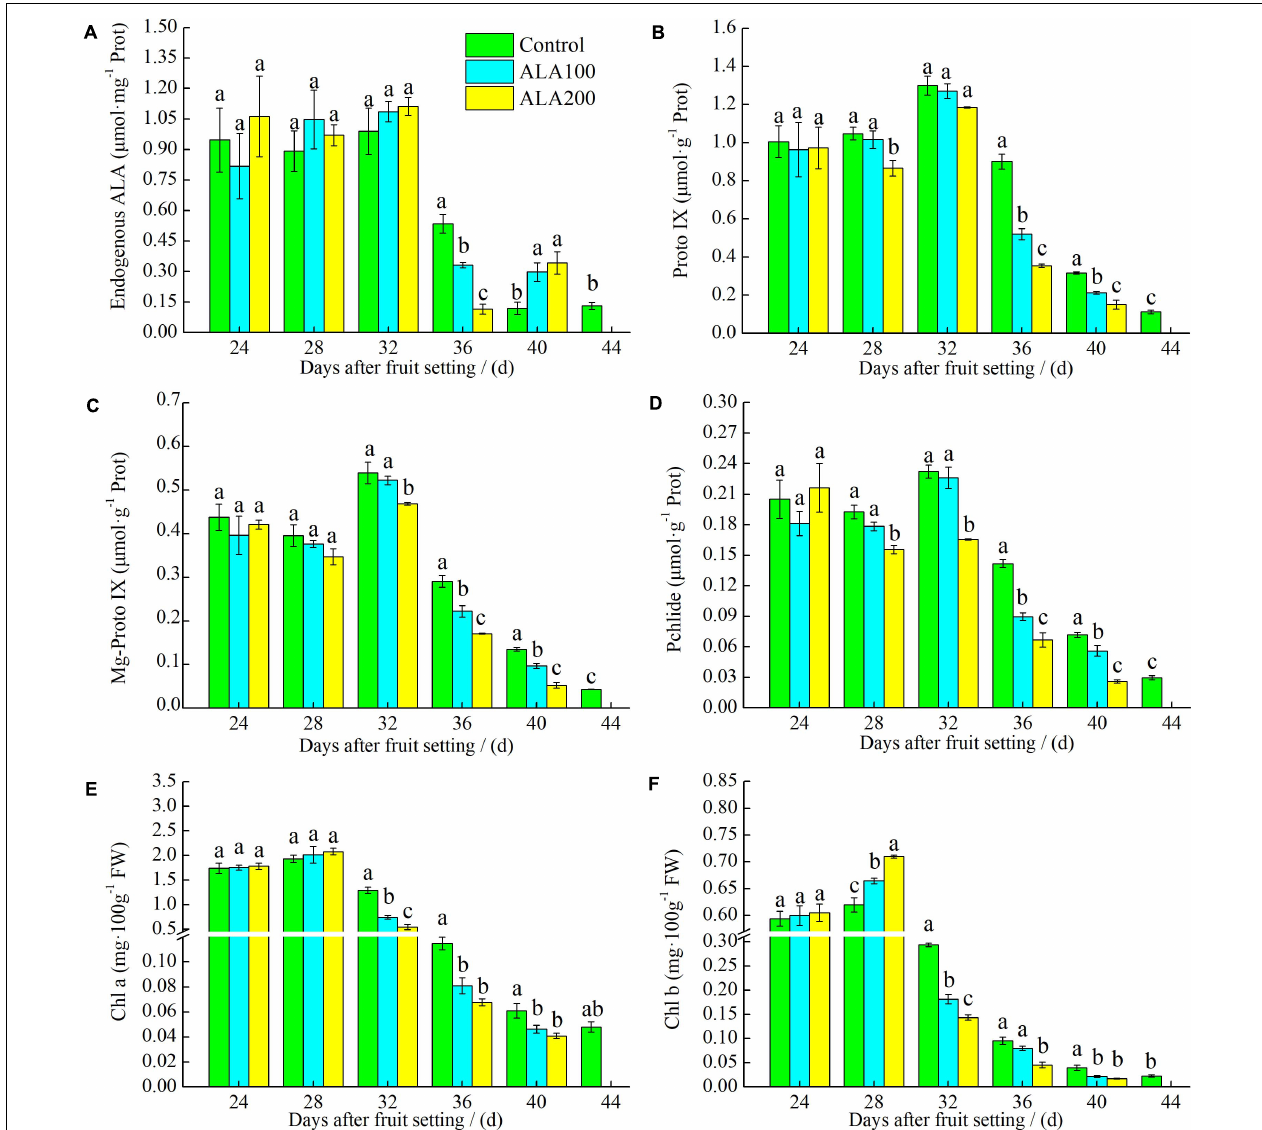
FIGURE 6 | The effects of ALA on endogenous derivatives of ALA metabolic pathway. (A) Endogenous ALA content; (B) Proto? content; (C) Mg-Proto? content; (D) Pchlide content; (E) Chl a content; and (F) Chl b content of tomato fruits at 24th–44th day after fruit setting. The 44th day after fruit setting data of the control group and the 40th day after fruit setting data of other treatments were analyzed by ANOVA to separate its significance. Vertical bars represent mean ± SE from three independent replicates and the different letters denote significant differences ( p <